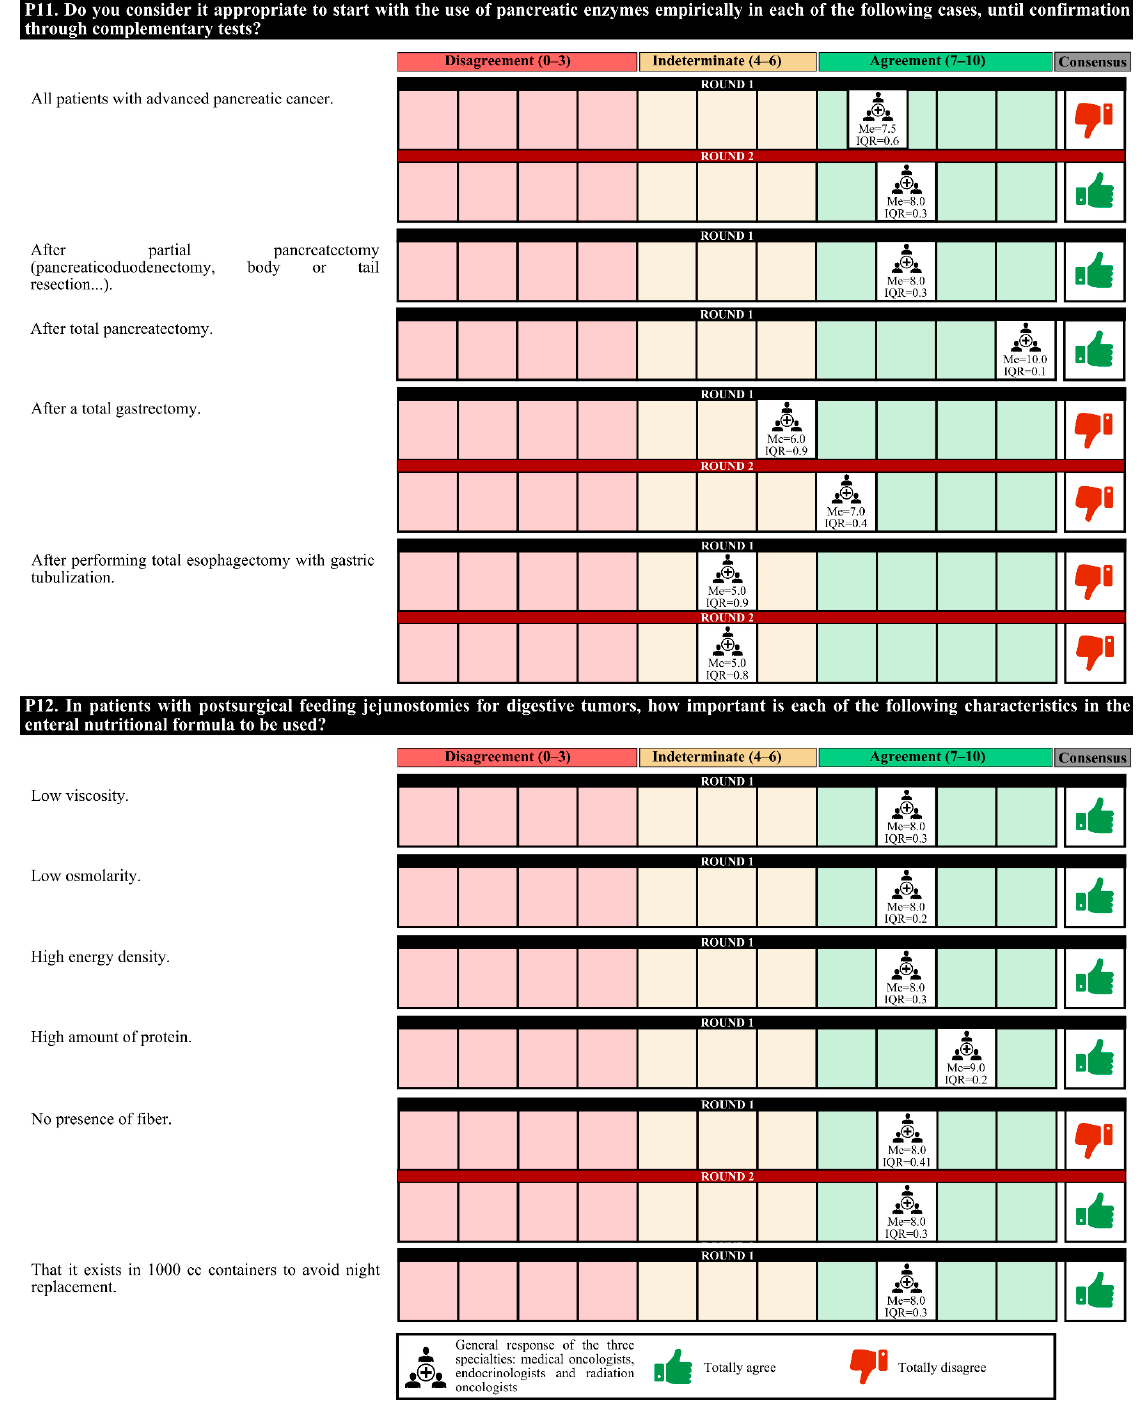
Figure 6. Answers about nutritional therapy (II). IQR, interquartile range; Me, median.